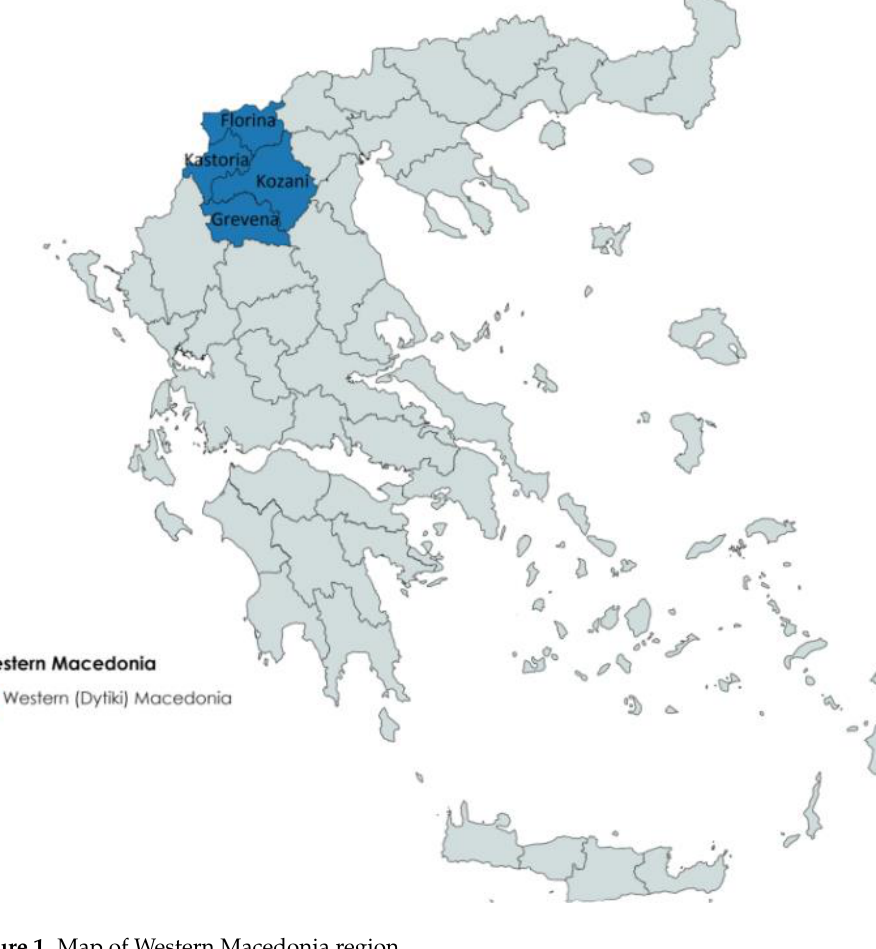
Figure 1. Map of Western Macedonia